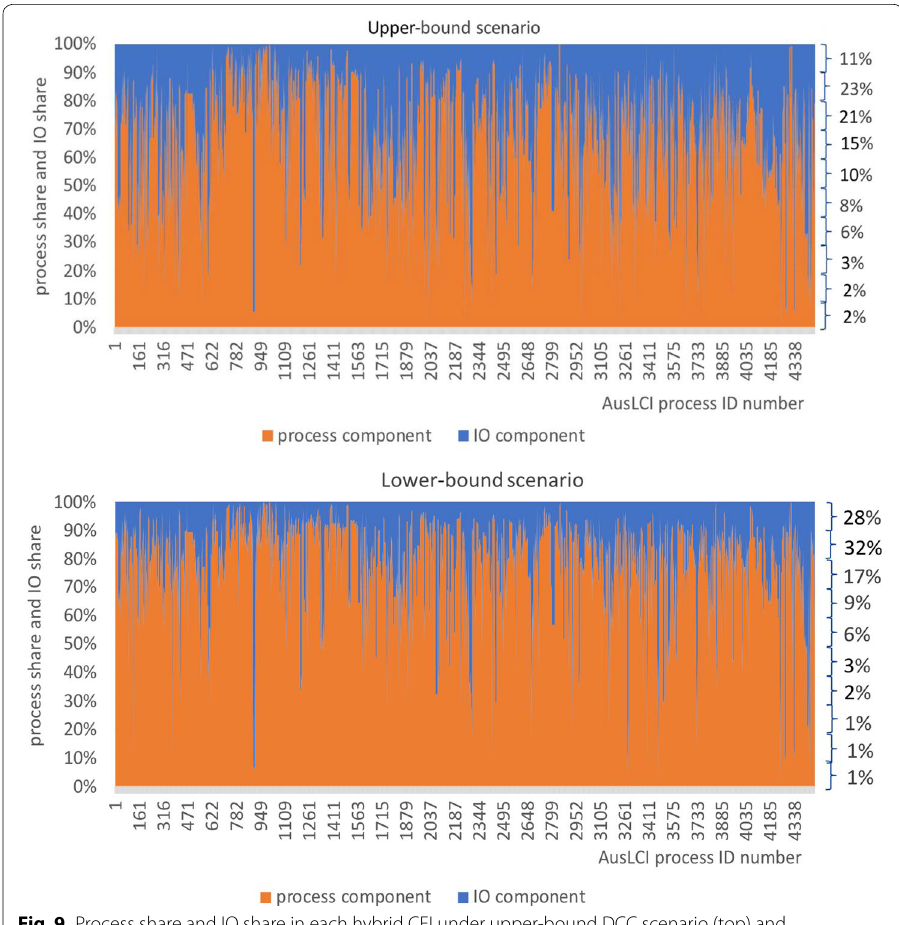
Fig. 9 Process share and IO share in each hybrid CFI under upper-bound DCC scenario (top) and lower-bound scenario (bottom). The percentages shown on the left-hand side (LHS) ordinate of each graph are the shares of process components. Deducting each of them from 100% gives the share of IO components. The values on the right-hand side (RHS) ordinate of each graph show the percentages of AusLCI hybrid CFIs whose process shares are located within the deciles of the LHS ordinate (adding up to 100%). For example, under lower-bound DCC, the process shares of 28% AusLCI hybrid CFIs are between 90% and